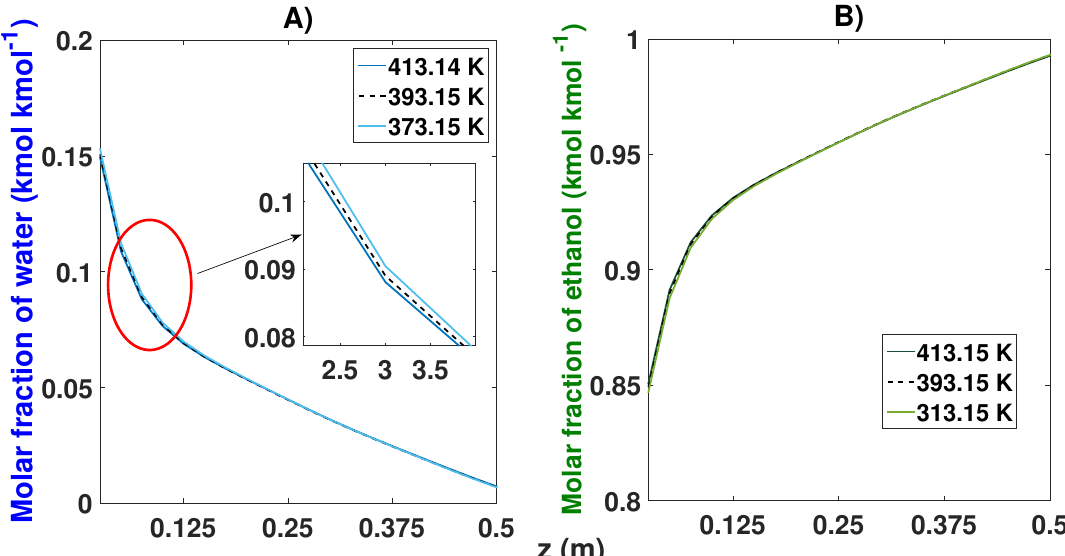
Figure 17. Molar fraction profile in the bed from the start-up and at CSS for three different feed temperatures. (A) Effect of feed temperature on the molar fraction of water; (B) Effect of feed temperature on the molar fraction of ethanol.